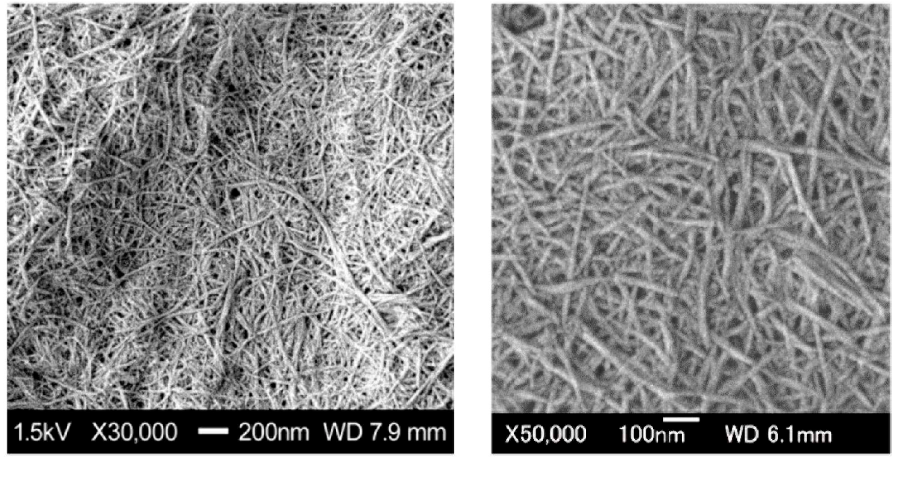
Figure 3. SEM images of chitin nanofibers from crab shell after grinder